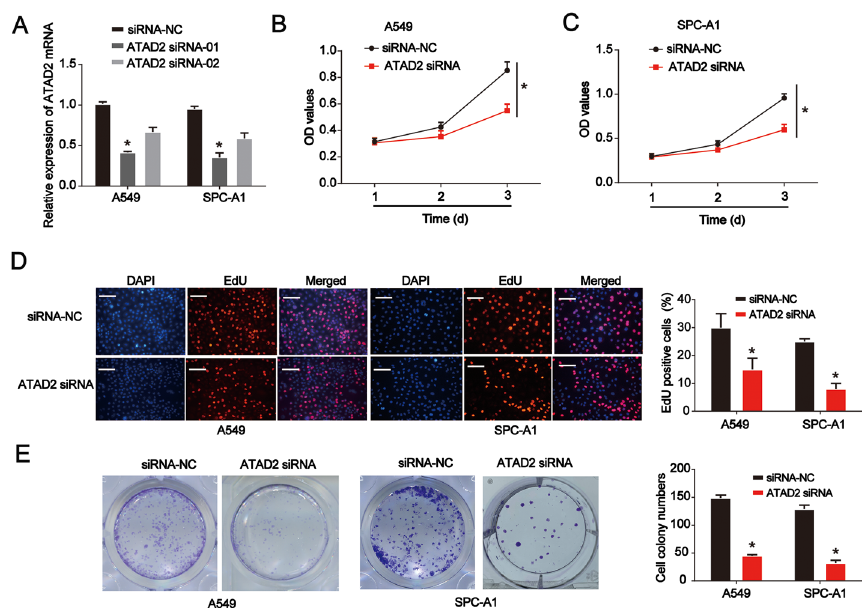
Fig. 2 Effects of ATAD2 on lung cancer cell viability and proliferation. A Validation of siRNA knockdown efficiency in A549 and SPC-A1 cells as determined using RT-qPCR. B , C Cell counting kit (CCK)-8 proliferation assay in siRNA-negative control (NC) or siRNA-ATAD2-transfected A549 and SPC-A1 cells. D 5-Ethynyl-2 ′ -deoxyuridine (EdU) proliferation assay using siRNA-NC- or siRNA-ATAD2-transfected A549 and SPC-A1 cells. Scale bar 100 μm. E Colony-formation proliferation assay in siRNA-NC- or = siRNA-ATAD2-transfected A549 and SPC-A1 cells. Error bars indicate mean standard deviation (SD). All ± experiments performed in triplicate. * p < 0.05